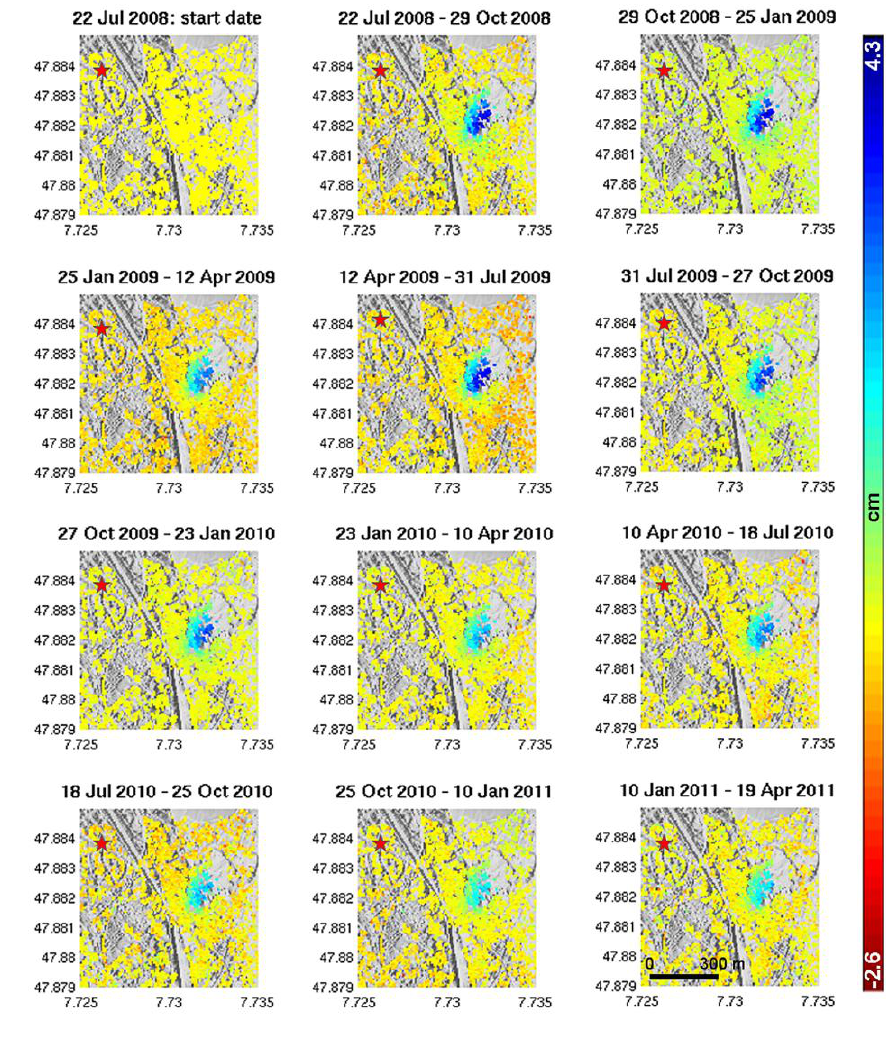
Figure 8. Deformation differences (in cm) of the uplift field between the acquisition dates selected in Figure